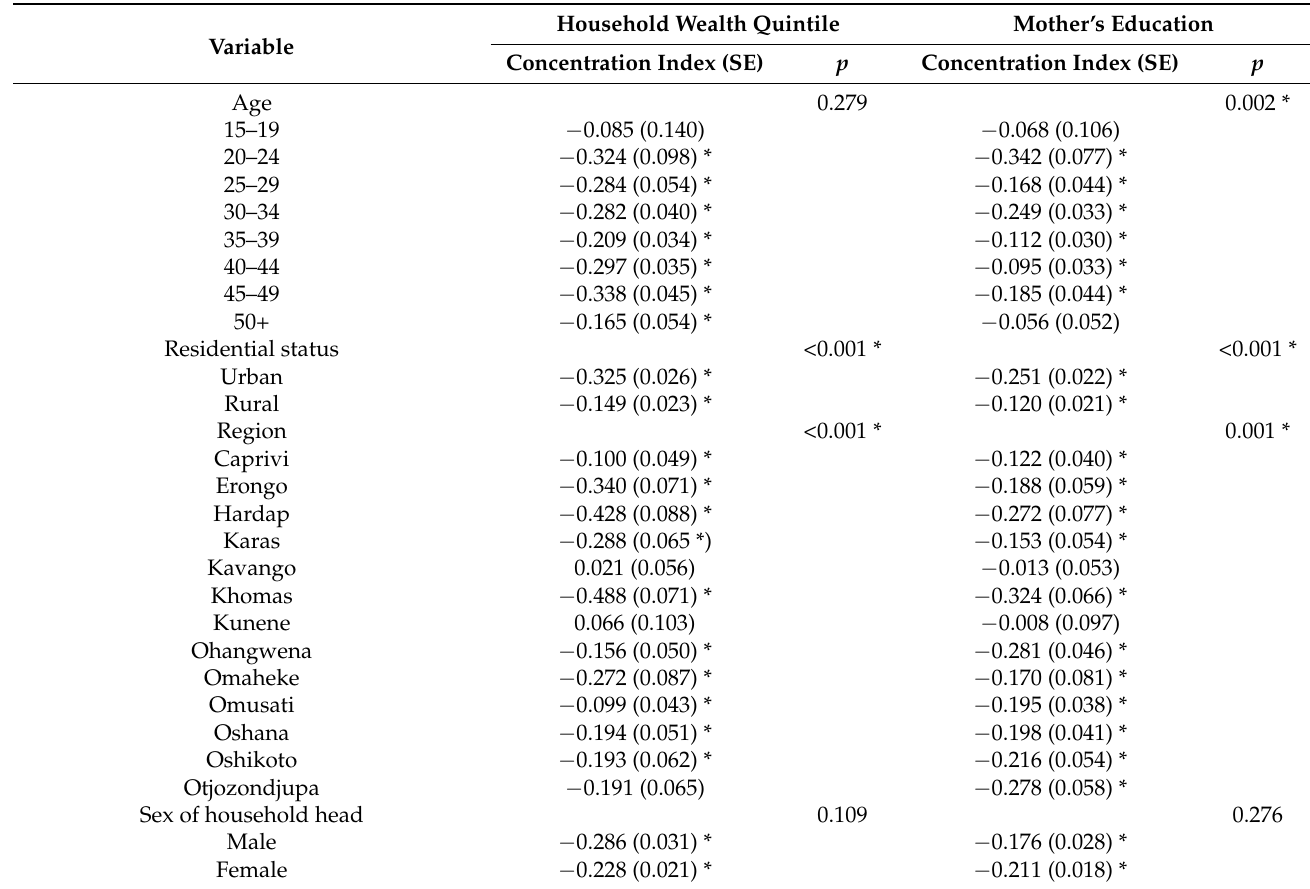
Table 5. Household wealth and educational attainment inequalities in HIV prevalence among Namibian women.